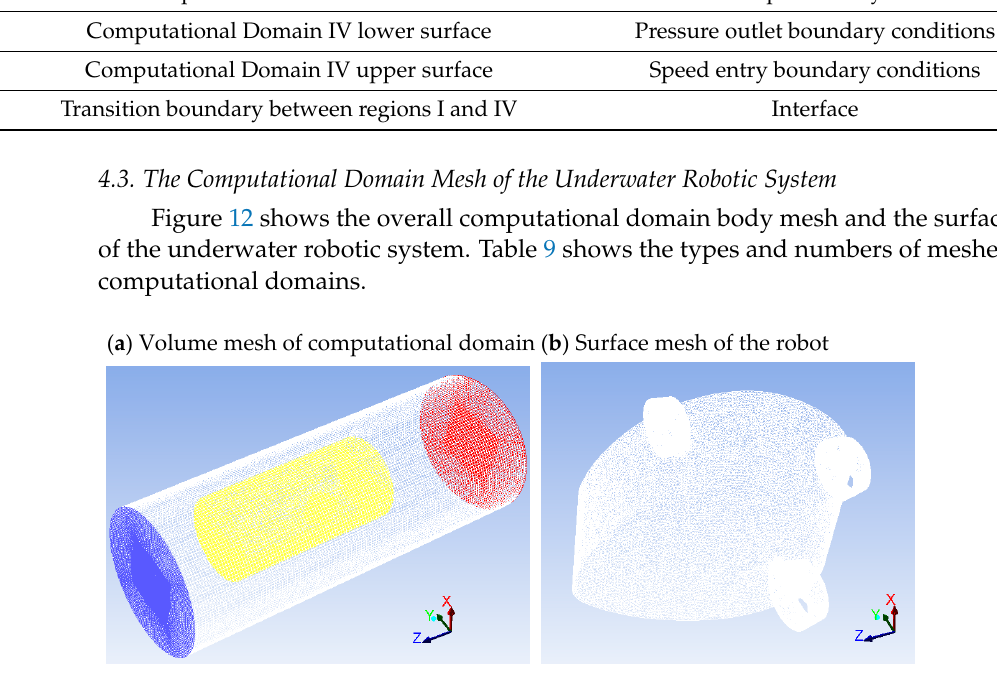
Figure 12. Computational domain meshes for the underwater robot system. ( a ) Volume mesh of computational domain; ( b ) Surface mesh of the robot.